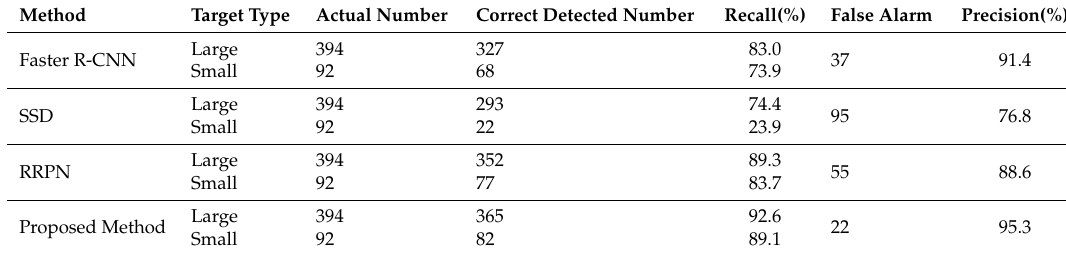
Table 2. Comparative results with other methods on our dataset.